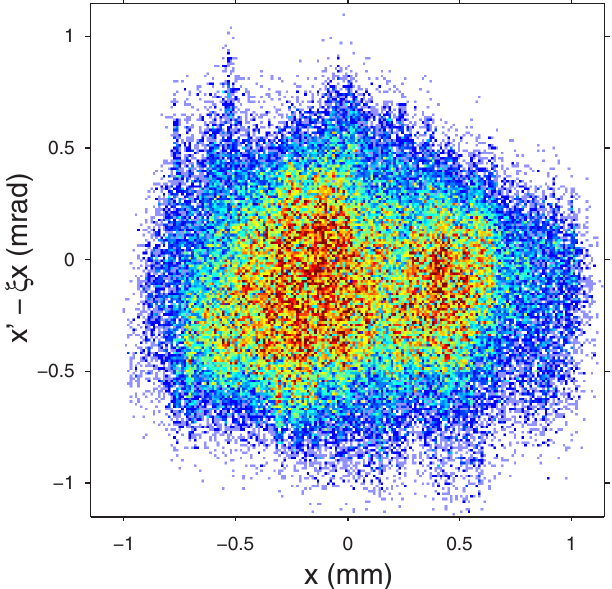
FIG. 9. (Color) Recovered phase space distribution in the ( x , x 0 (cid:1) (cid:7)x )